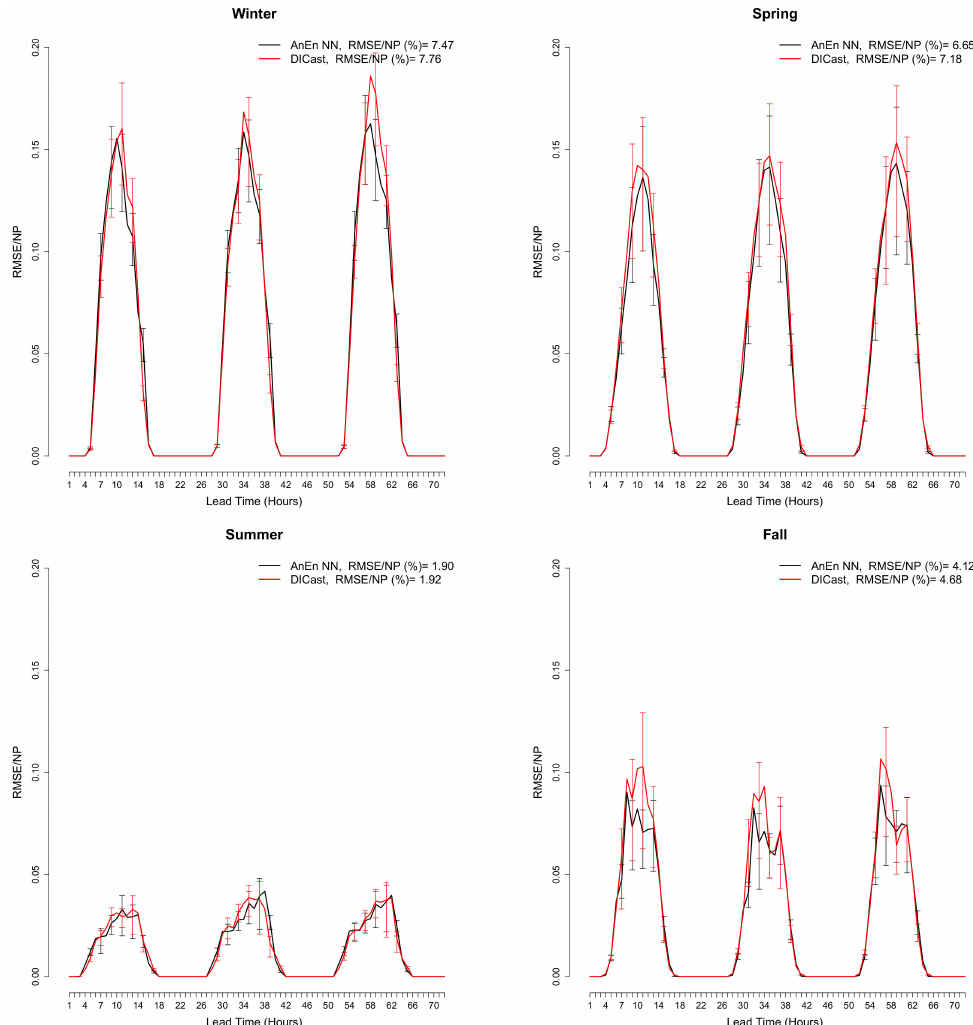
Figure 14. As Figure 13, but for solar power only with data stratified by